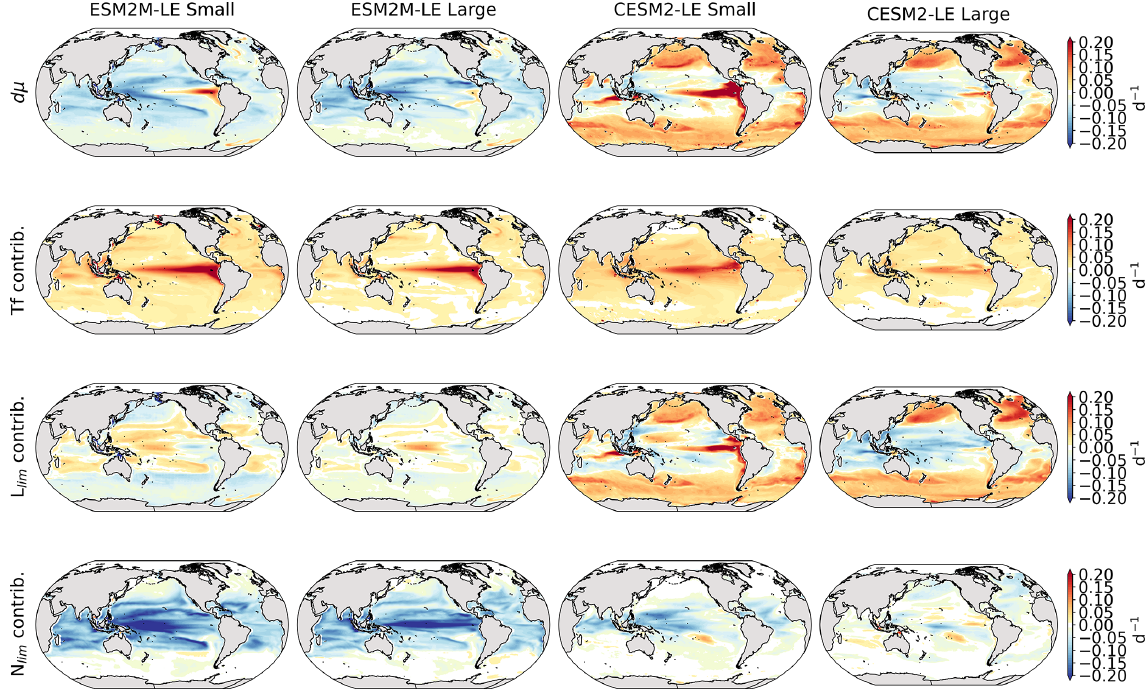
Figure 4. Growth rate anomaly d µ (d − 1 ) of small and large phytoplankton during compound MHW–NPPX events in ESM2M-LE (a, b) and in CESM2-LE (c, d) and contributions of a change in the temperature function T f (e–h) , in the light limitation L lim (i–l) , and in the nutrient limitation N lim (m–p) to this growth rate anomaly. The decomposition of d µ into these three contributions comes with a global mean residual of 0.009 and − 0.002d − 1 for small and large phytoplankton in ESM2M-LE and of − 0.007 and 0.002d − 1 for small and large phytoplankton in CESM2-LE.